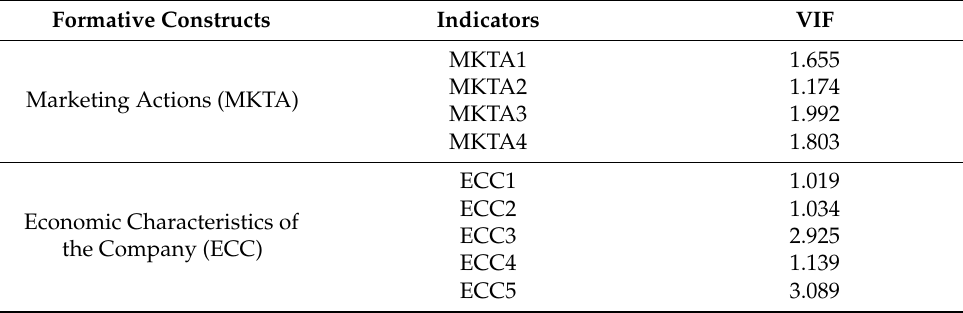
Table 5. Collinearity assessment: VIF values of the formative measurement models.